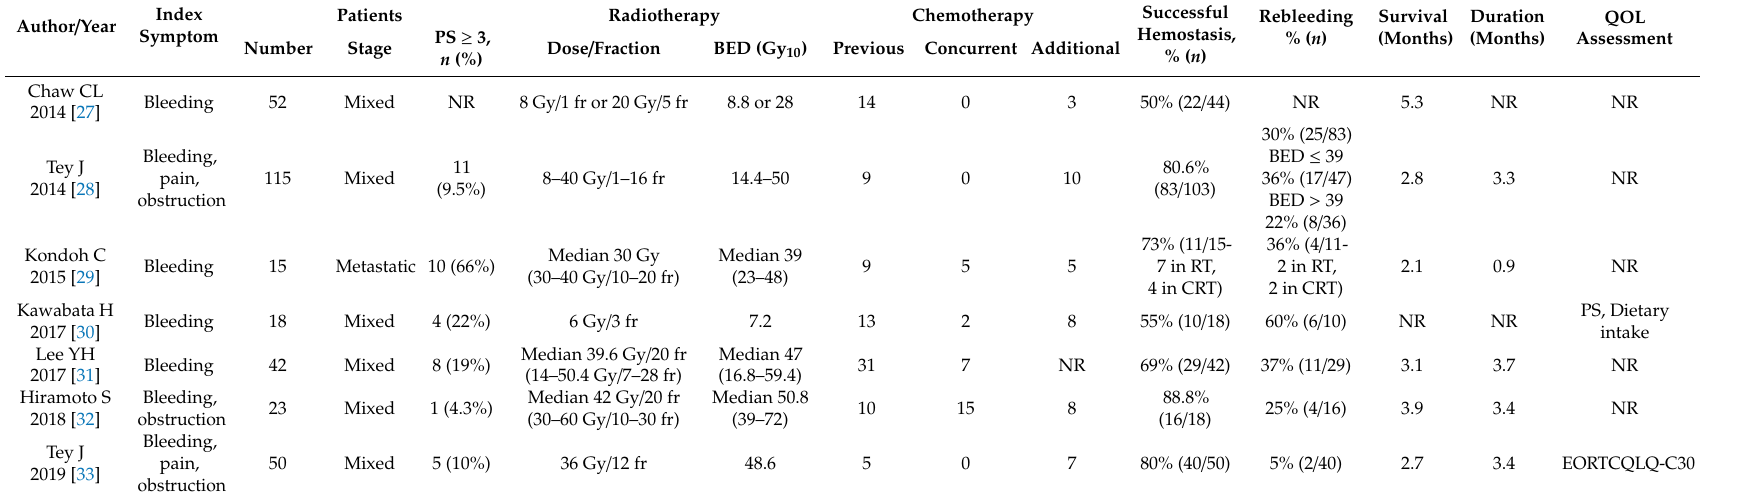
Table 3. Characteristics and results of palliative radiotherapy for bleeding from gastric